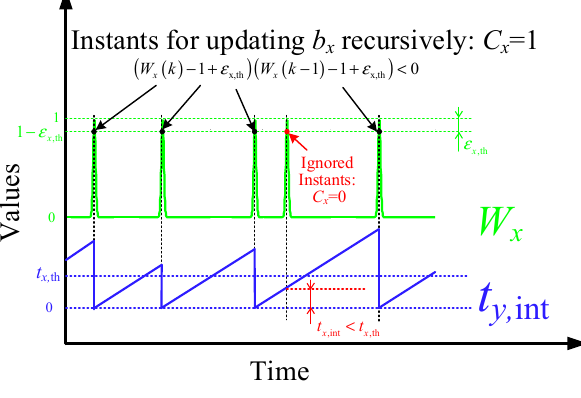
Figure 5. The instants for updating b x recursively.